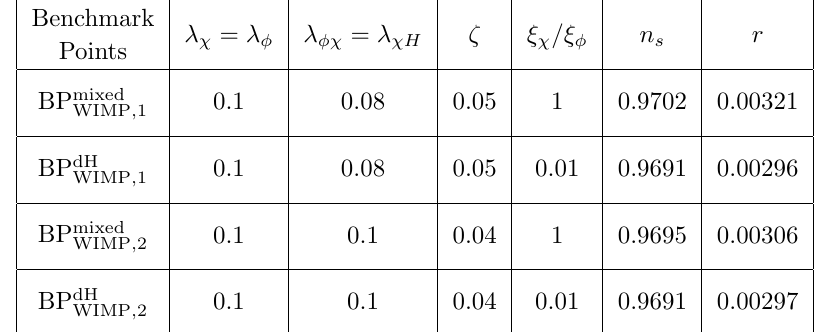
Table 1 . Input parameters for the benchmark points, denoted as black points in (cid:12)gures 1 and 2. In this case, m Z 0 is also (cid:12)xed to m Z 0 = 67 GeV, in the upper two and lower two cases, respectively. The superscript represents the in(cid:13)ation type; for example, BP mixed point where mixed (dark Higgs) in(cid:13)ation is